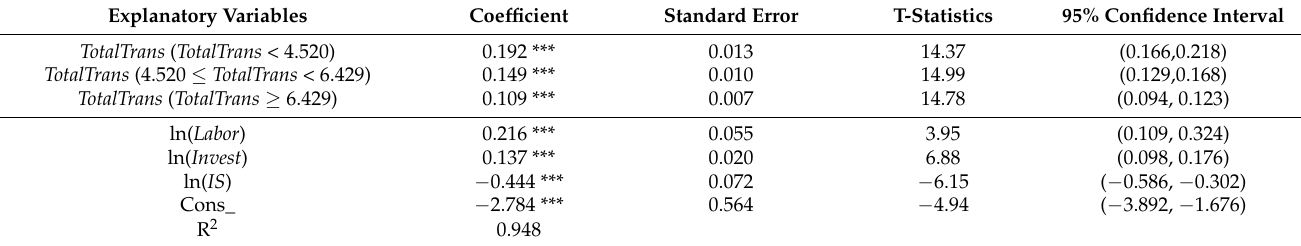
Figure 4. Results of double threshold LR estimation. ( a ) Results of the first threshold LR estimation; ( b ) Results of the second threshold LR estimation. Table 7. Results of the double threshold regression